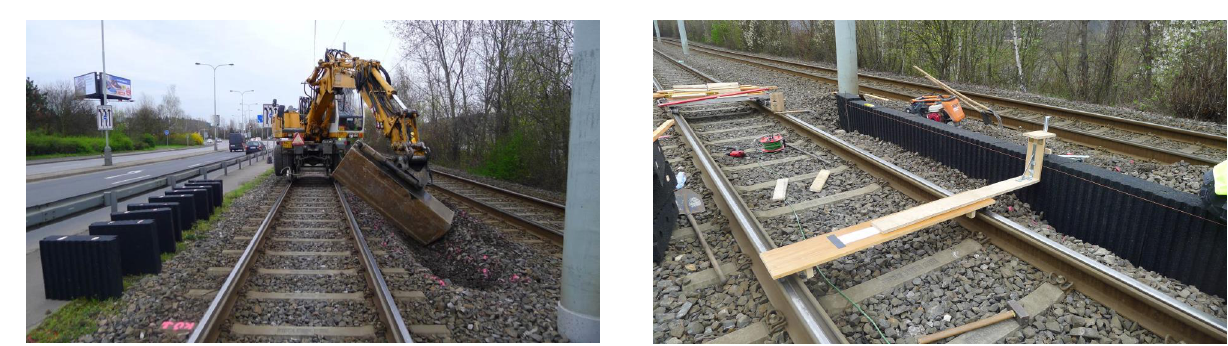
Figure 7. Checking the screen distance and height from the rail axis and